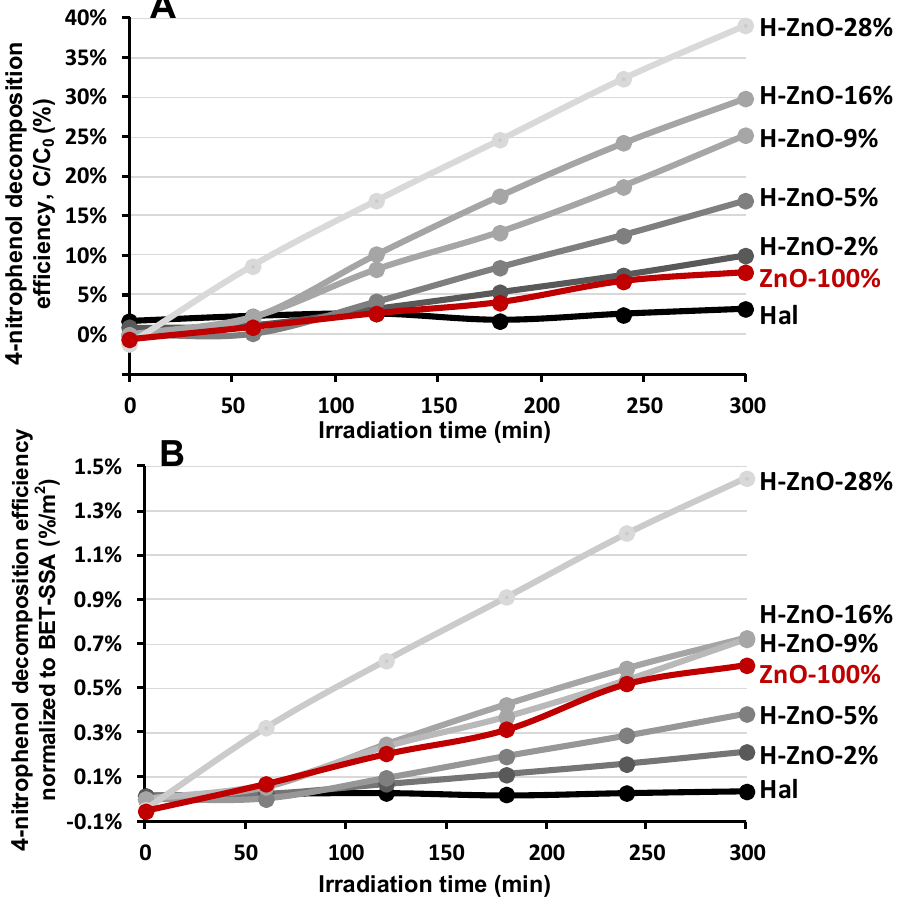
Figure 5. Decomposition efficiency of 4-nitrophenol determined by UV absorption. ( A ): compared to initial concentration, ( B ): normalized to specific surface area (BET-SSA).